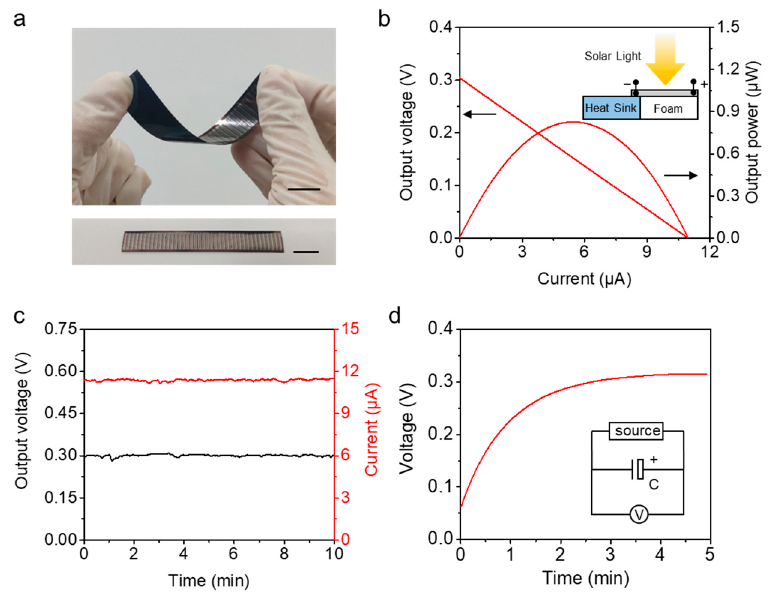
Figure 5. Performance testing of the thin-film solar thermoelectric generators. ( a ) Photograph of the thin-film solar thermoelectric generator (upper) and the TE patterns (lower). The scale bar represents 1.5 cm. ( b ) The I–V and I–P characteristics of the film under the illumination intensity of 1 kW · m − 2 . ( c ) The output stability of the film. ( d ) The voltage charging curve for a 2200 μ F capacitor powered by the thin-film solar thermoelectric generator. The inset shows the charging circuit.